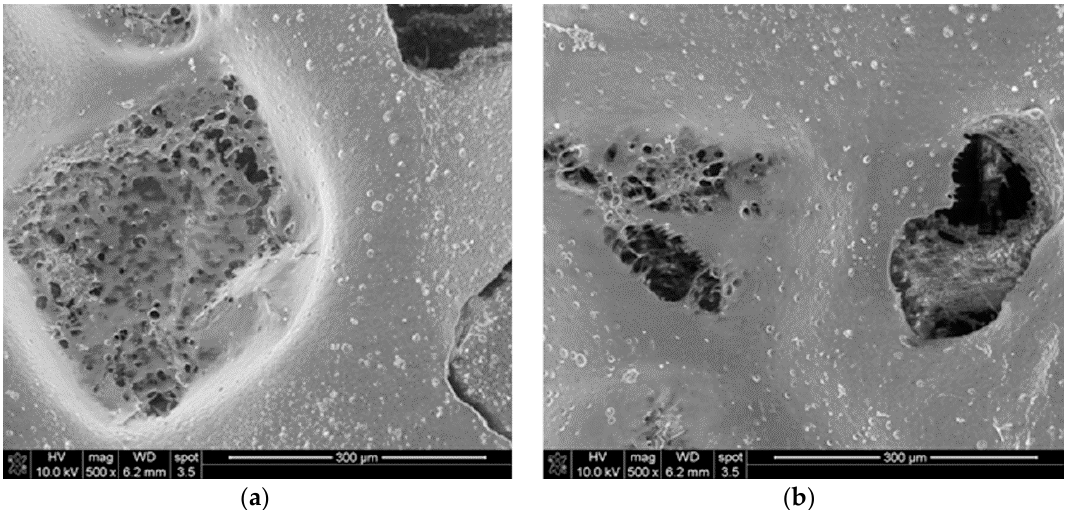
Figure 6. The SEM picture of the porous structure obtained as a result of the salt-leaching method in the enlarged scale. Polymer concentration 5%, polymer solution to salt mass ratio 10/6, solvent-ethanol, salt-natrium chloride with particle diameter 0.16–0.40 mm. ( a ) Imaging of the shape of porophor’s crystal; ( b) documents the open pore character.